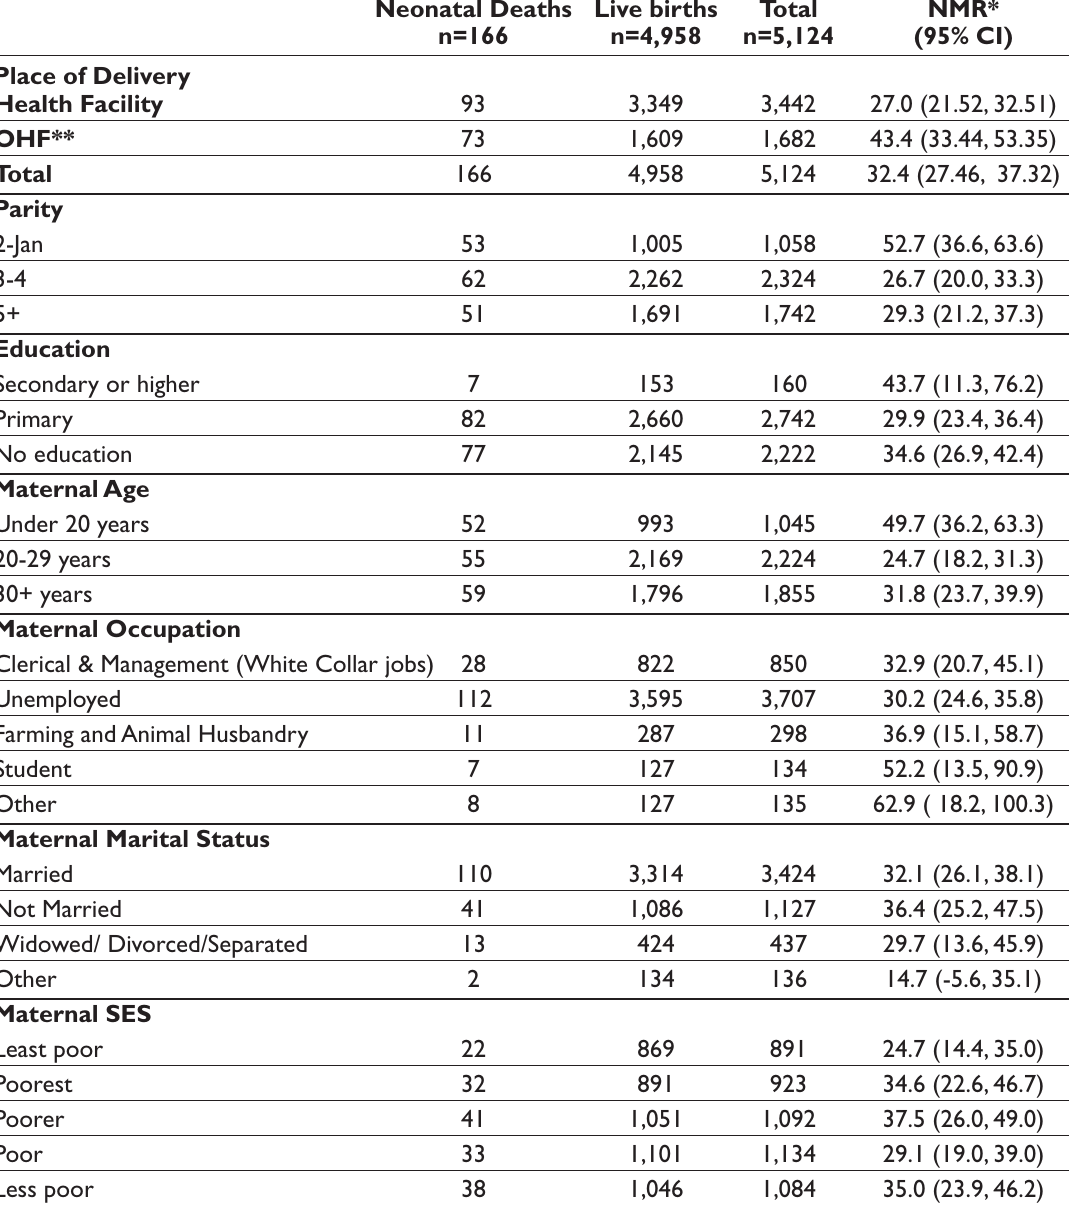
Table 2. Distribution of Neonatal Mortality Rates by Place of Delivery per 1000 Live Births, Rufiji Health and Demographic Surveillance System (HDSS), Tanzania